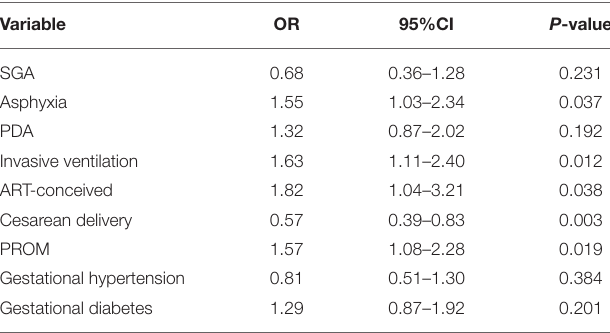
TABLE 3 | Multivariate analyses of mother and neonate variables associated with